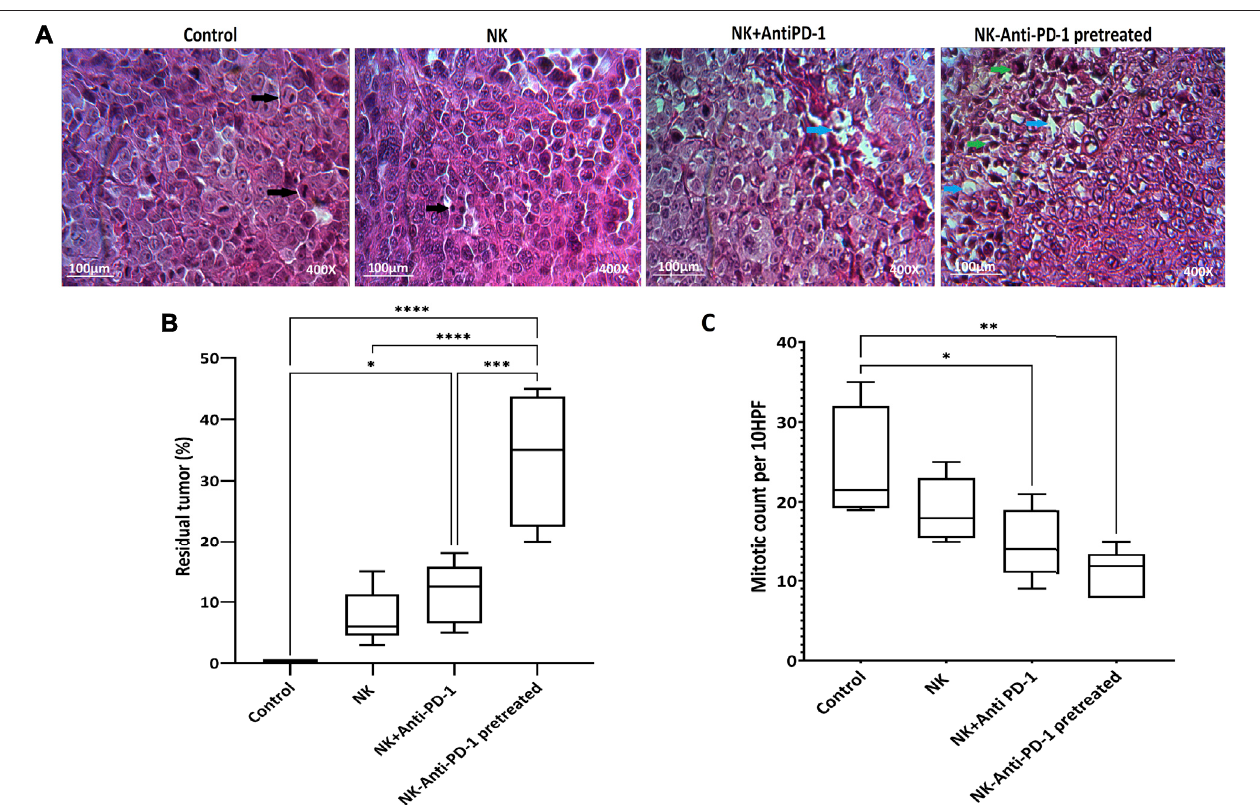
FIGURE 5 | Histopathological fi nding. (A) Representative Hematoxylin and Eosin (H and E). Black arrows showed mitosis, blue arrows showed fi brotic areas, and green arrows showed apoptotic bodies. (B) Boxplots showed tumor responsebased on the residual tumor. (C) Mitotic count as proliferation score assessed in 10HPF; anaphasecelldivisionstageisvisibleinthecontroltissuesample.Datapresentedasmeans ± standarderror(M ± SE).Statisticalsigni fi cancewasdeterminedusingone- way ANOVA with * p < 0.05. Scale bar: 100 µm, 400X magni fi